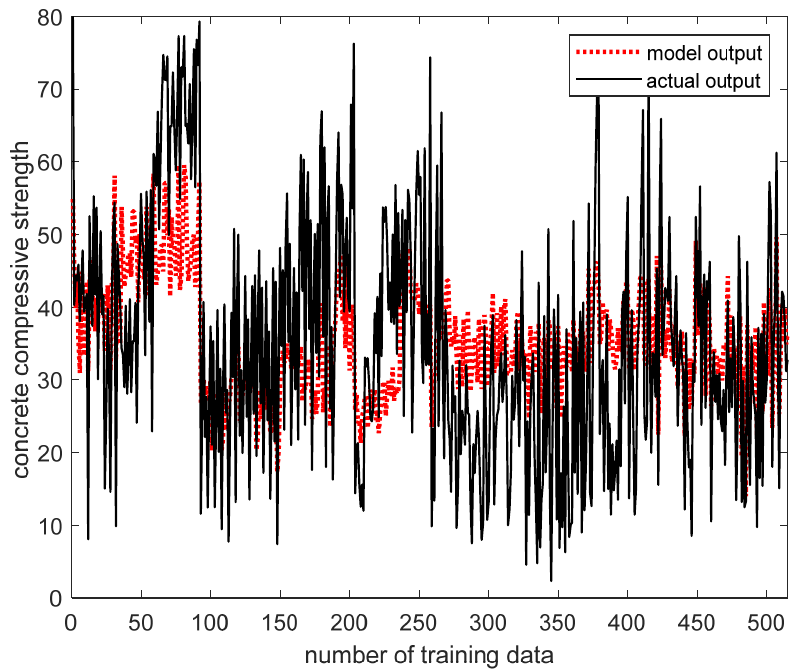
Figure 9. Comparison of the output of the CGK-based fuzzy granular model and real output (uniform generation of contexts, number of contexts = 6, number of clusters = 4).